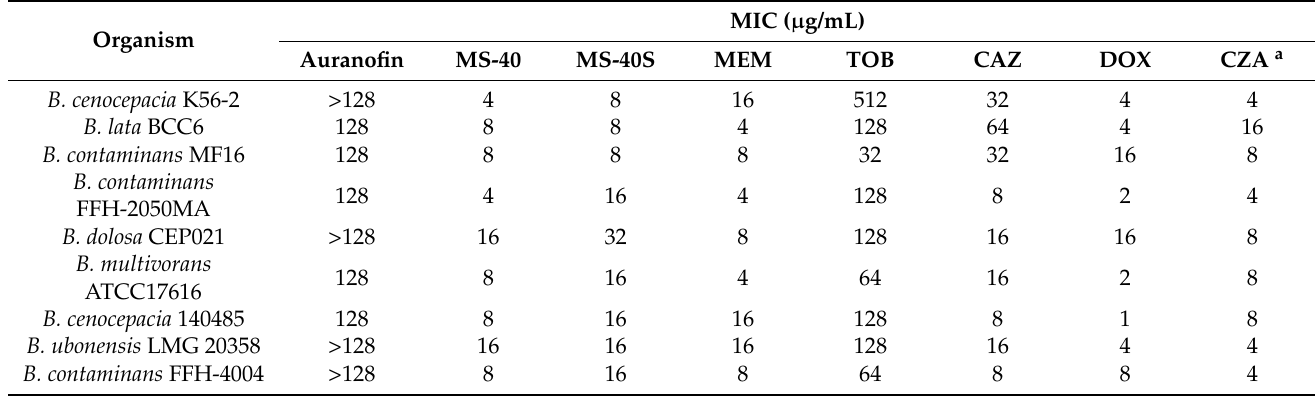
Table 2. Minimum inhibitory concentrations (MICs) of MS-40S compared to clinical antibiotics used to treat CF patients.